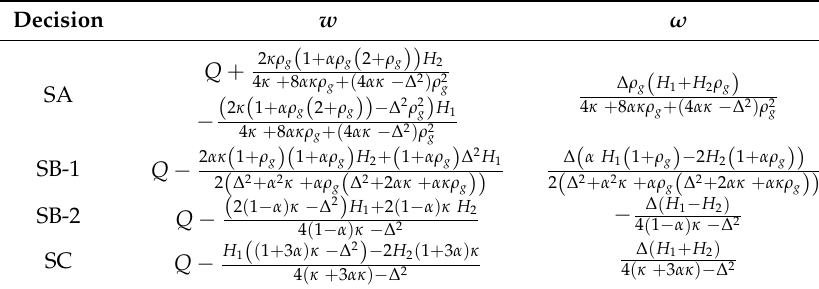
Table 2. The supplier’s optimal wholesale price and product